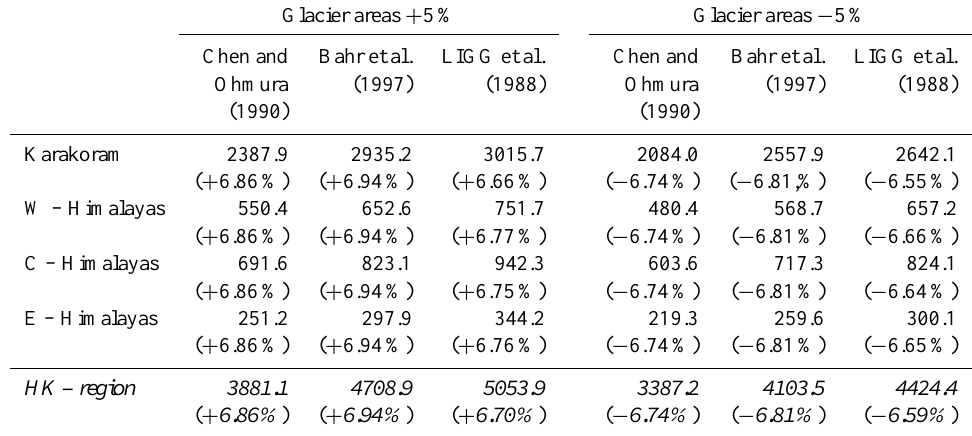
Table 5. Total ice volumes (km 3 ) calculated with V–A relations, using glacier areas modified by ± 5%; relative differences in